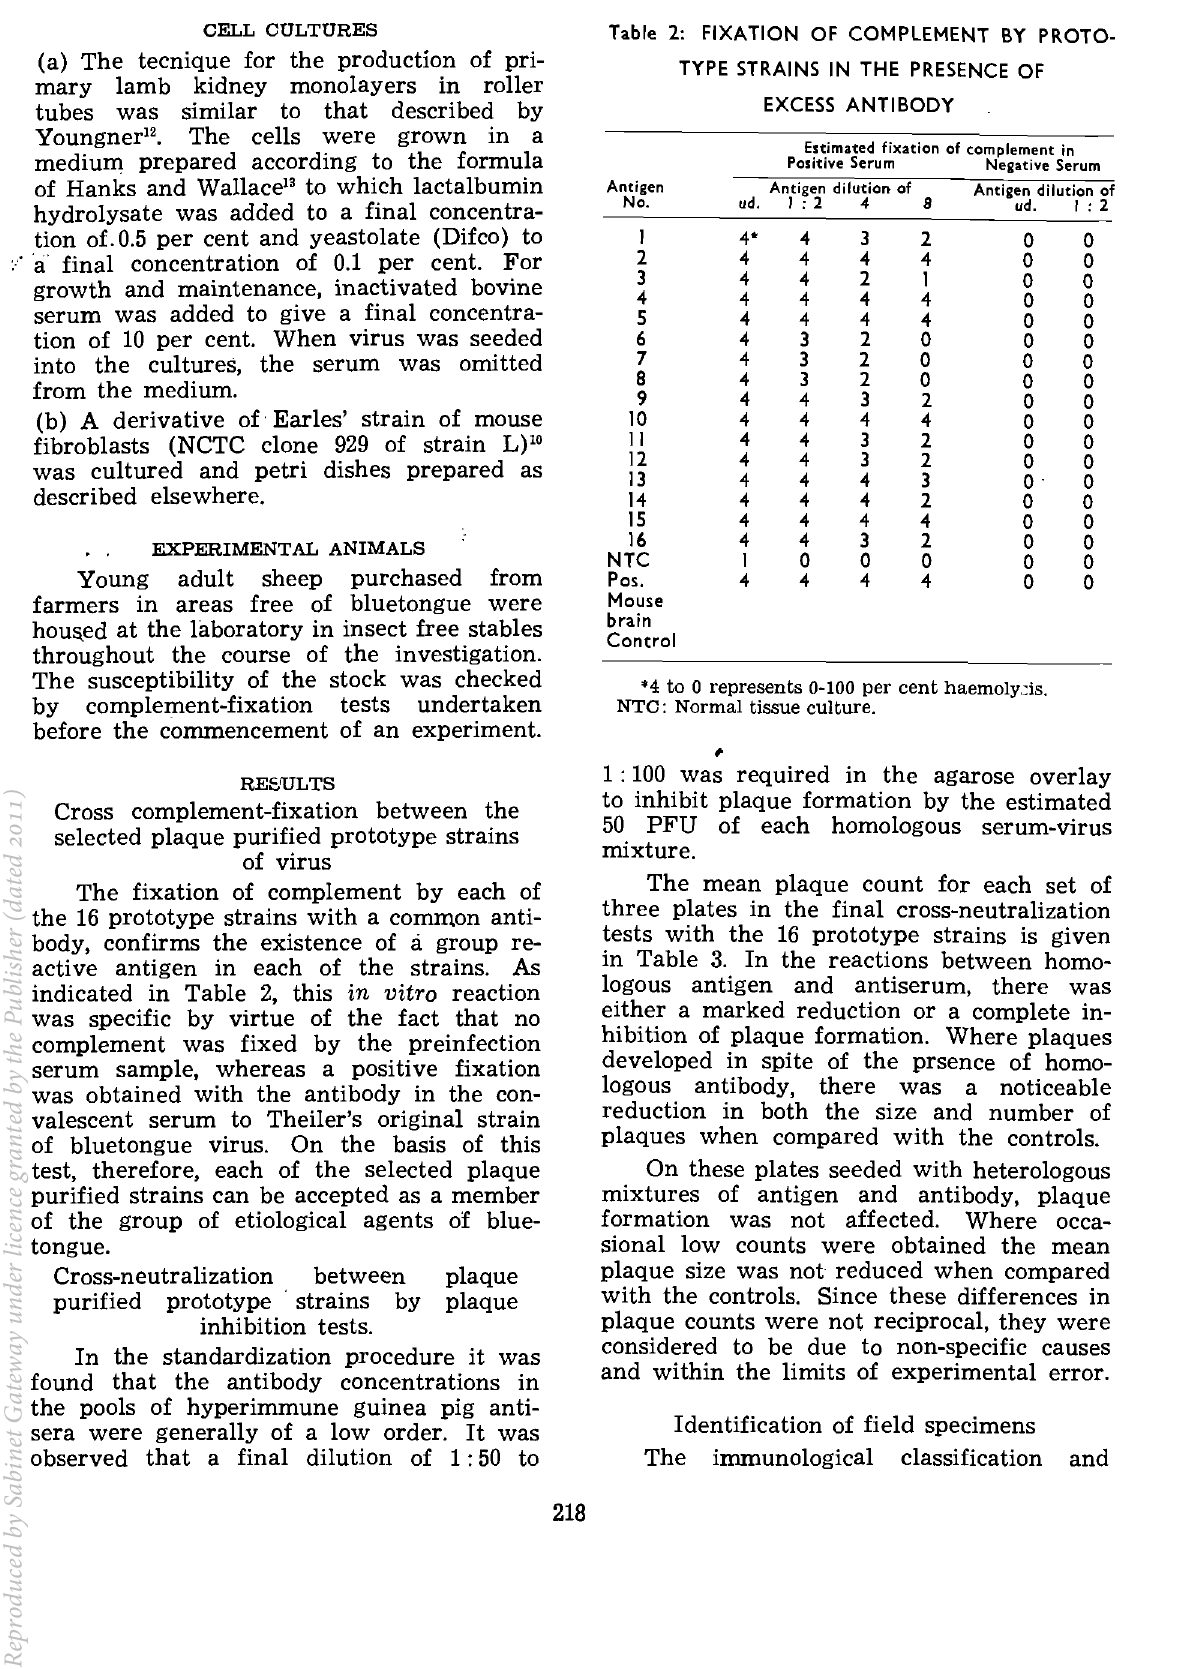
Table 2: FIXATION OF COMPLEMENT BY